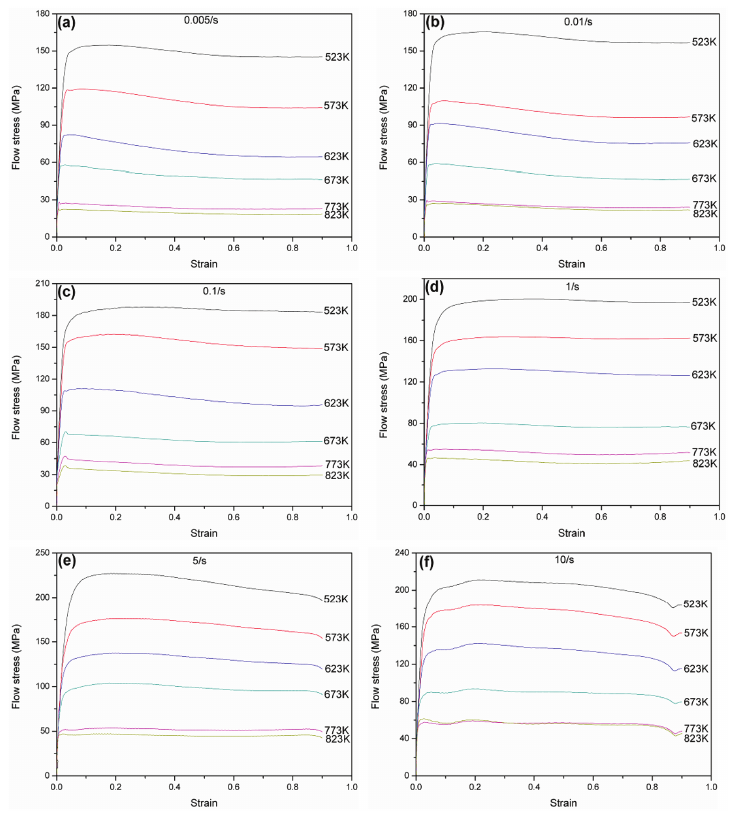
Figure 4: Flow stress – strain curves of pure aluminum at strain rate of: (a) 0.005s − 1 ; (b) 0.01s − 1 ; (c) 0.1s − 1 ; (d) 1s − 1 ; (e) 5s − 1 and (f) 10s − 1